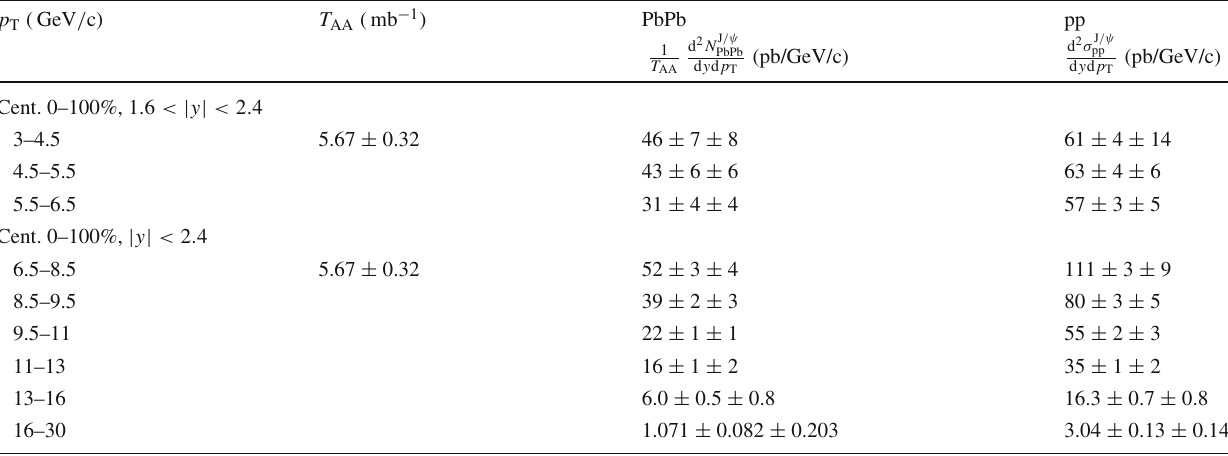
Table 7 The nonprompt J /ψ fiducial cross section in bins of p T , mea- sured in PbPb and pp collisions at 2.76TeV within the muon acceptance defined by Eq. (4), and the nuclear overlap function ( T AA , with its sys- tematicuncertainty).Listeduncertaintiesarestatisticalfirstandsystem-